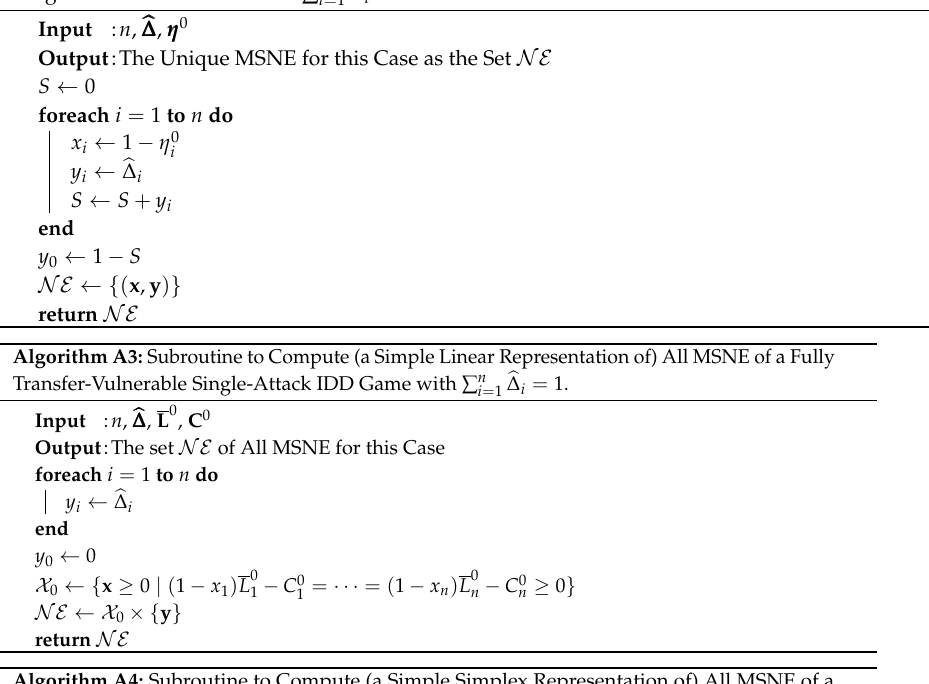
Algorithm A2: Subroutine to Compute the Unique MSNE of a Fully Transfer-Vulnerable Single-Attack IDD Game with ∑ n i =